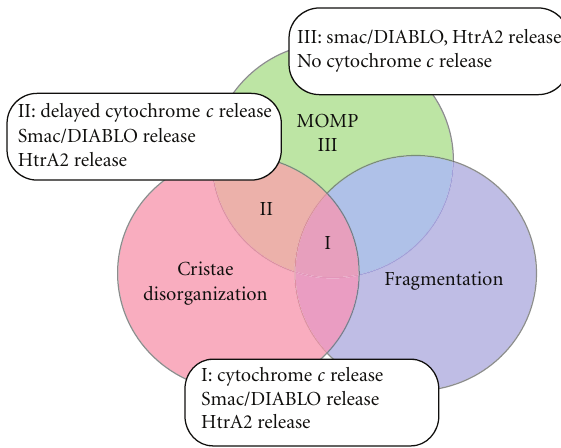
Figure 2: Relation between mitochondrial structural changes and the release of IMS-stored apoptogenic factors. During apoptosis in wild-type cells, mitochondrial fragmentation normally occurs con- comitantly with MOMP, cristae disorganization, and subsequent release of the IMS-stored apoptogenic factors (e.g., cytochrome c , smac/DIABLO, HtrA2/omi). Mitochondrial fission facilitates these reactions (State I). In contrast, elongated but cristae-disrupted mitochondria (i.e., Drp1- and OPA1-double RNAi cells; Drp1- KO and OPA1 RNAi cells) exhibit a significant delay only in the cytochrome c release in response to apoptotic stimuli, because of the absence of mitochondrial fragmentation. Of note, however, MOM targeting and oligomeric assembly of Bax and the release of the IMS-soluble Smac/DIABLO normally proceed (State II). State III: presumed MOM permeabilized state in the absence of both cristae disorganization and mitochondrial fragmentation. MOMP: mitochondrial outer membrane